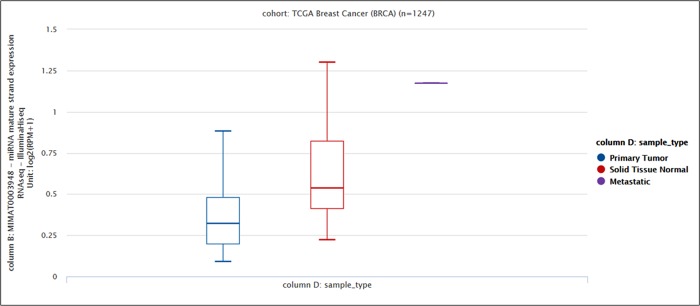
Lower expression of miR-770-5p is associated with tumor samples.Expression level of miR-770-5p was downregulated in tumor samples compared to normal samples (One-way ANOVA; p<0.00005621, f = 10.44).